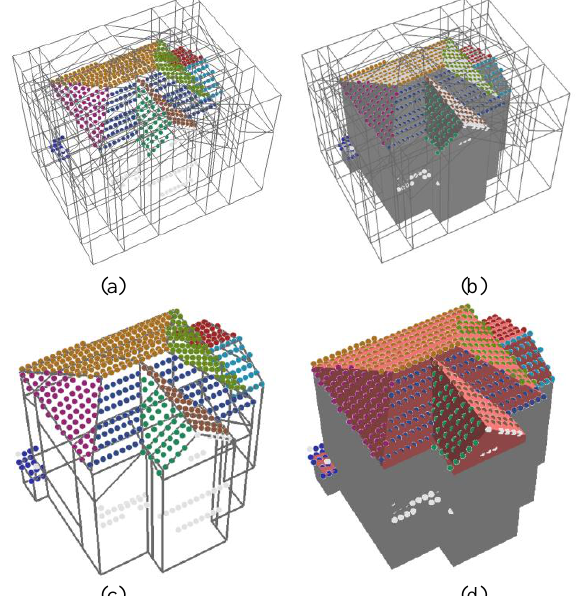
Figure 5 Segmented roof LiDAR points and reconstructed model: (a)space partitioning, (b) binary labeling of cells, (c)surface extraction and (d) reconstucted model. Roof point clouds are colored by their planar segments.